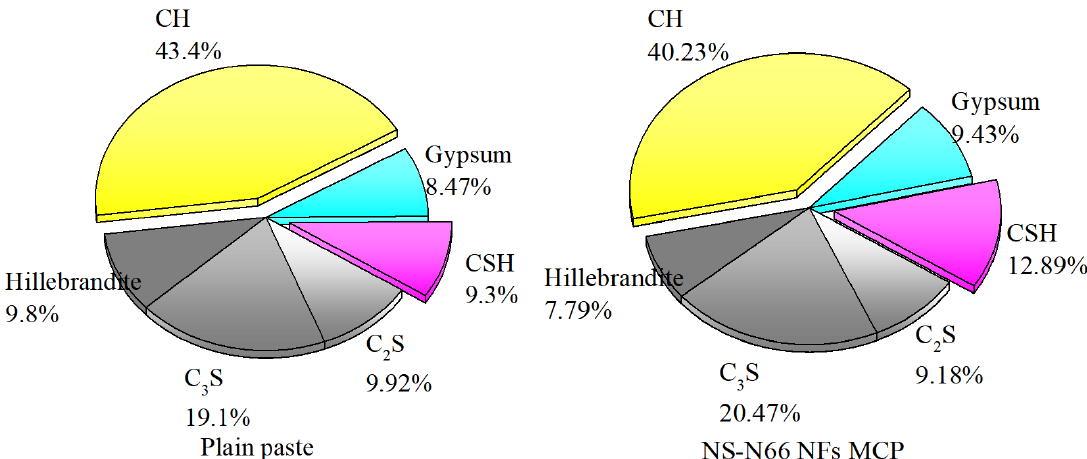
Figure 6. Component proportions of the cement matrices observed from the XRD results.